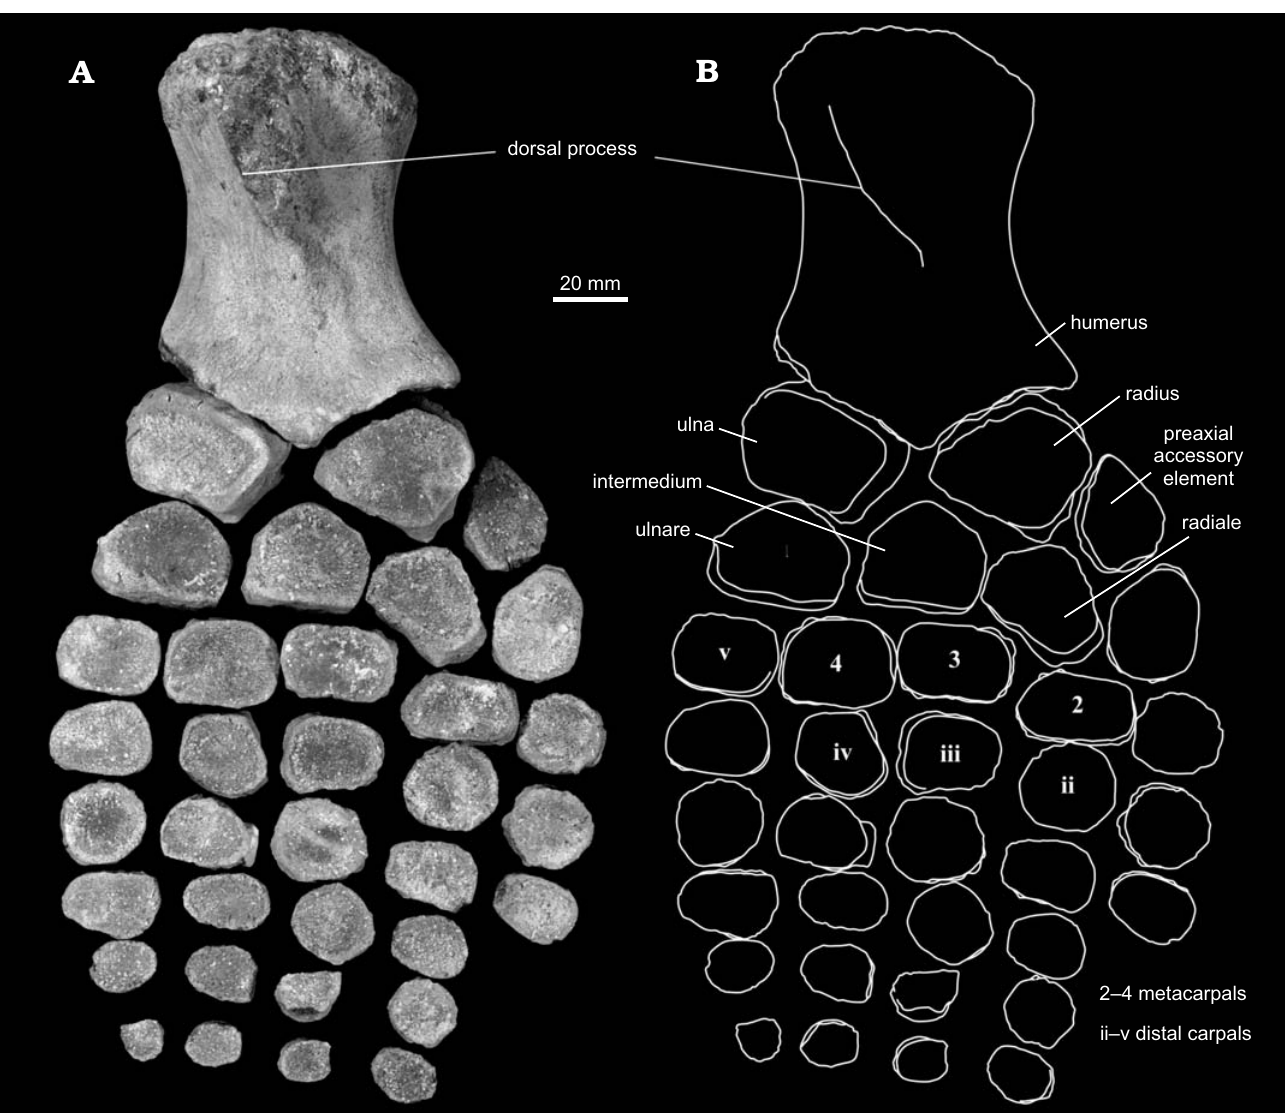
Fig. 7. Right forefin of ophthalmosaurid ichthyosaur Cryopterygius kielanae sp. nov. (GMUL 3579-81, holotype) from the Late Jurassic of Owadów- Brzezinki Quarry; photo of the reconstruction ( A ) and explanatory drawing ( B ) in dorsal